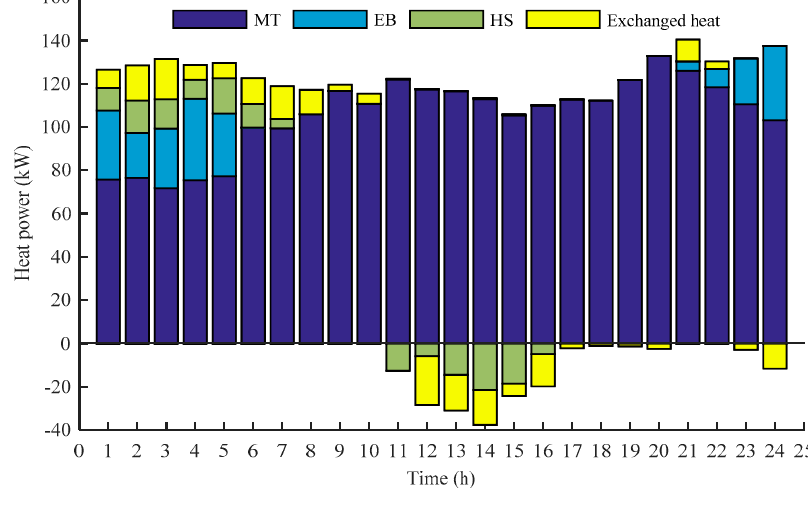
Figure 7. Results of heat power.